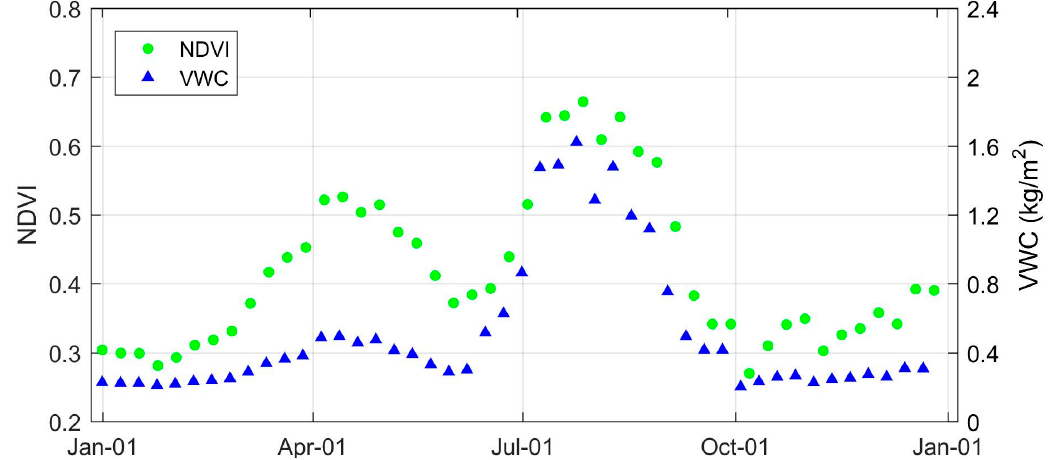
Figure 3. The averaged Normalized Difference Vegetation Index (NDVI) of all the CASMOS stations in 2016. The green circles represent the averaged NDVI from the Aqua and Terra satellites; the blue triangles represent the averaged vegetation water content (VWC) calculated from the NDVI data. Again, the growing seasons of wheat and corn are from early October to the next June and from June to late September, respectively.